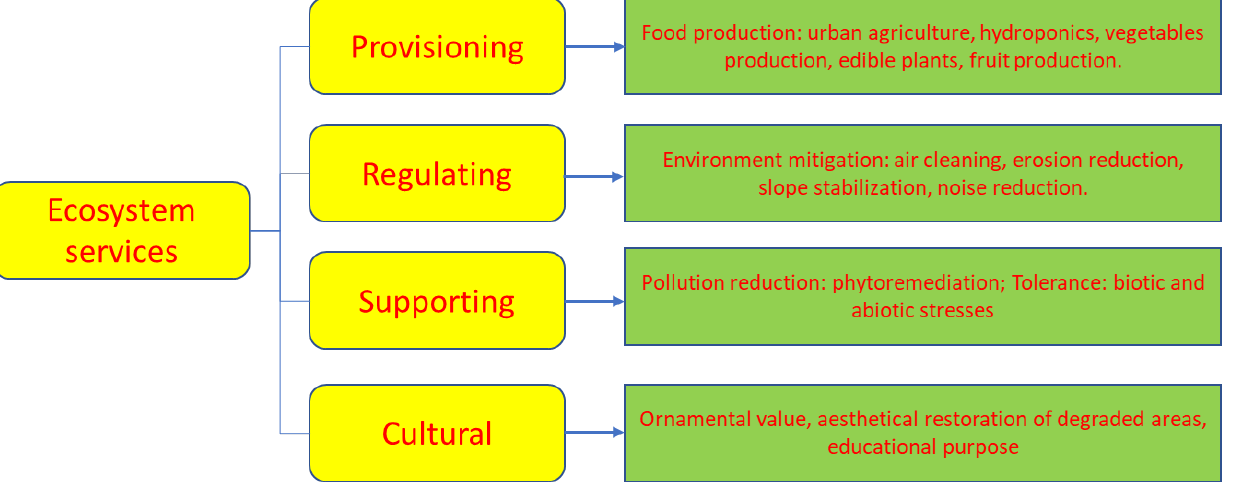
Figure 1. Ecosystem services and connections with benefits obtained from adequate green area planning and distribution in an urban or peri-urban area.